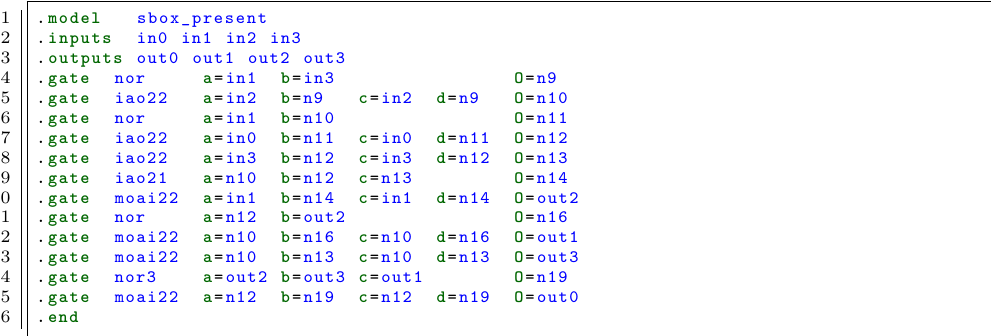
Figure 18: Combination of LIGHTER and ABC: Area-optimized hardware implementation of PRESENT Sbox using 22.50 GE with the standard cell library of the TSMC 65nm logic